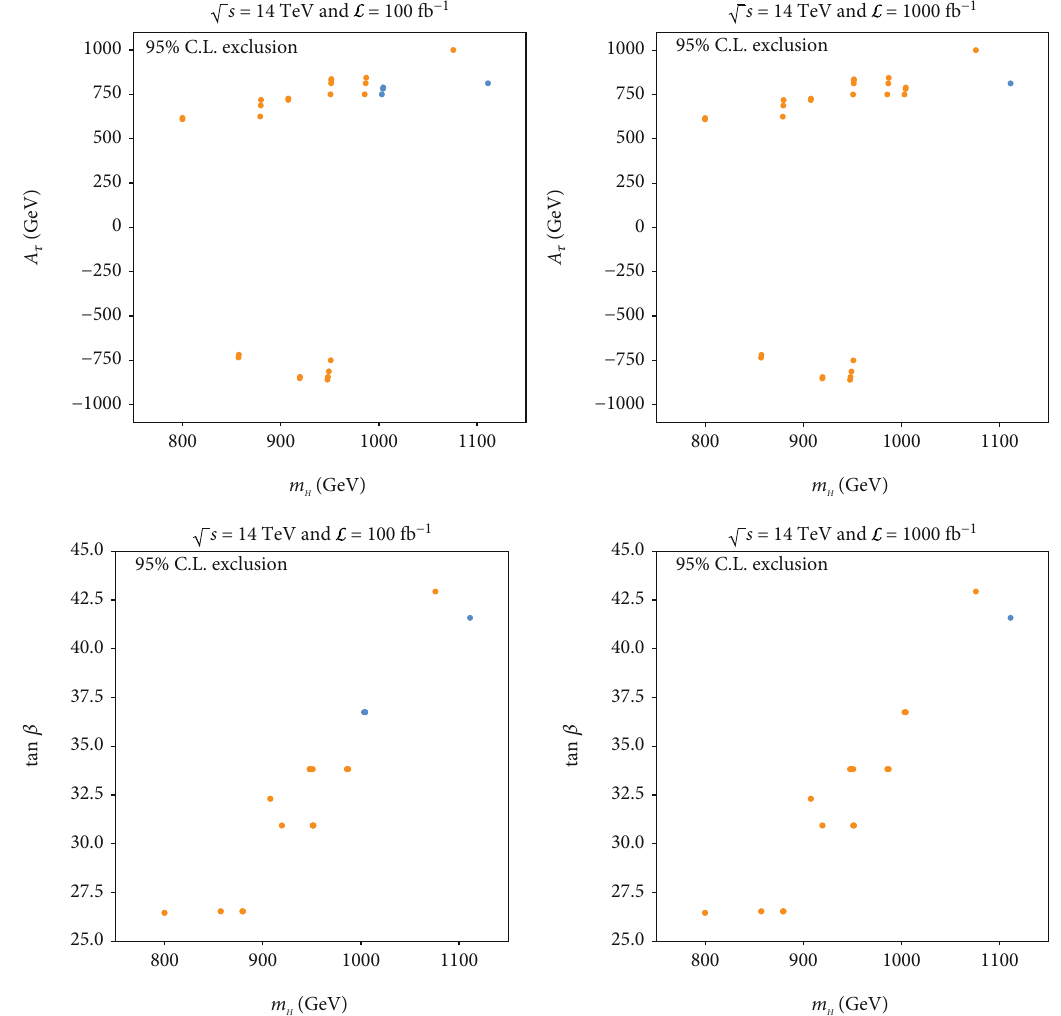
Figure 2: Potential exclusion at 95% C.L. obtained from Equation (15) in the ½ m Scenario I, for a center-of-mass energy of display in orange the benchmark points that are excluded at 95% C.L. and in blue those that are